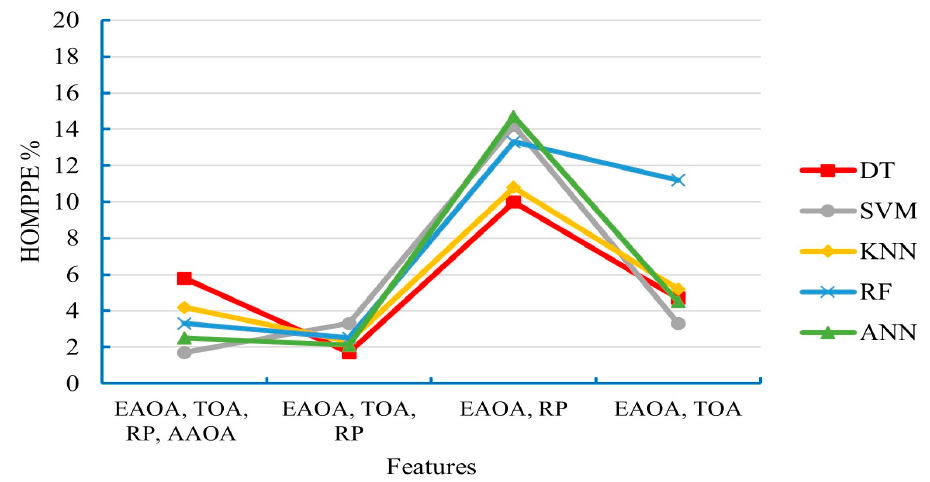
Figure 10. Impact of features selection on the accuracy.